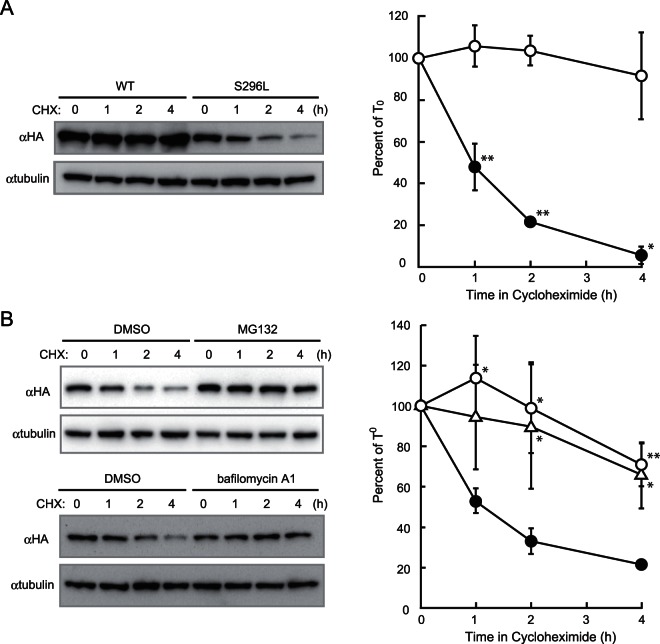
S296L mutation causes hZnT2 destabilized.(A) The expression level of the hZnT2 protein at each time point. The ZnT1
−/−
MT
−/−
ZnT4
−/− cells expressing WT hZnT2 or S296L mutant were treated with CHX and collected periodically over 4 h. Immunoblot analysis was performed to monitor hZnT2 levels (left panel). The band intensities of hZnT2 protein (○, WT; •, S296L mutant) are shown as the percentage of the intensity at 0 h (T0) after normalized by that of tubulin at each time (right panel). * and ** denote a significant difference between expression levels of the WT and S296L mutant hZnT2 at each time point (* P<0.05, ** P<0.01) (B) Lysosome inhibitor bafilomycin A1 and proteasome inhibitor MG132 block the degradation of S296L hZnT2 mutant. Immunoblot analysis (left panel) and the band intensities of hZnT2 protein (○, MG132; Δ, bafilomycin A1; • no inhibitor, right panel) are shown. In the right panels of both (A) and (B), each value is the mean ± SD of triplicate experiments. The same membrane was used for detection of both hZnT2 and tubulin. Tubulin is shown as a loading control. * and ** denote significant differences between expression levels in the absence and presence of bafilomycin A1 or MG132 at each time point (* P<0.05, ** P<0.01).